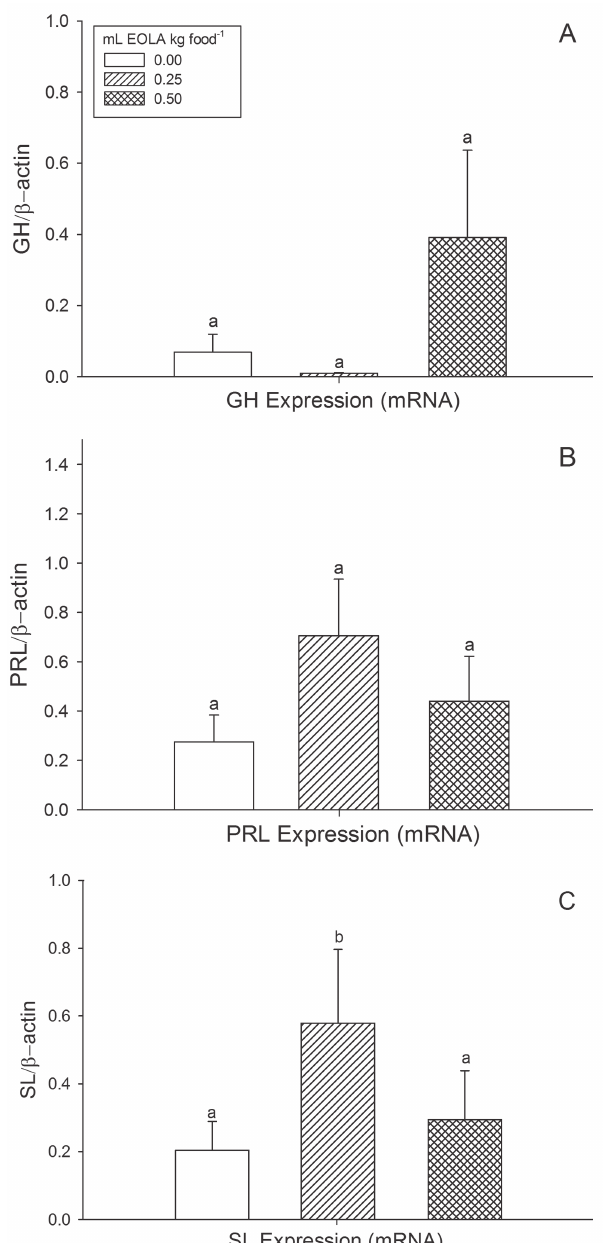
Fig. 4. Expression of pituitary hormones of Rhamdia quelen fed with different concentrations of dietary essential oil of Lippia alba (EOLA). A) growth hormone (GH), B) prolactin (PRL) and C) somatolactin (SL). Mean ± SEM. Different letters indicate significant differences (P < 0.05) between